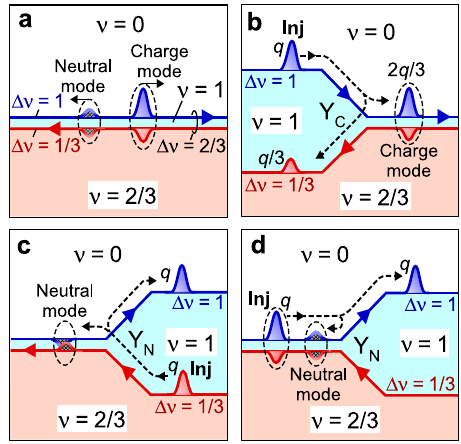
Fig. 1 QH Y-junctions formed with Δ ν = 1, 2/3, and 1/3 channels. a The charge and neutral modes in the disorder dominated regime of a composite Δ ν = 2/3 channel comprising Δ ν = 1 (blue) and 1/3 (red) channels along the boundaries of a hole-conjugate QH region with ν = 2/3, a narrow integer state with ν = 1, and the electronic vacuum ( ν = 0). Excitations are represented by positive and negative wave packets with ratios of charges in Δ ν = 1 and 1/3 channels (1: − 1/3 for the charge mode and 1: − 1 for the neutral mode). b Charge fractionalization at junction Y C . An incoming wave packet with charge q in the Δ ν = 1 channel is fractionalized into two packets with 2 q /3 (comprising q and − q /3) in the Δ ν = 2/3 channel and q /3 in the Δ ν = 1/3 channel. c , d Neutral re fl ections at junction Y N . An injected packet with charge q in the Δ ν = 1/3 channel splits into charge q in the Δ ν = 1 channel and neutral excitation (comprising − q and q ) in the Δ ν = 2/3 channel in c , and so as the packet in the Δ ν = 2/3 channel in d